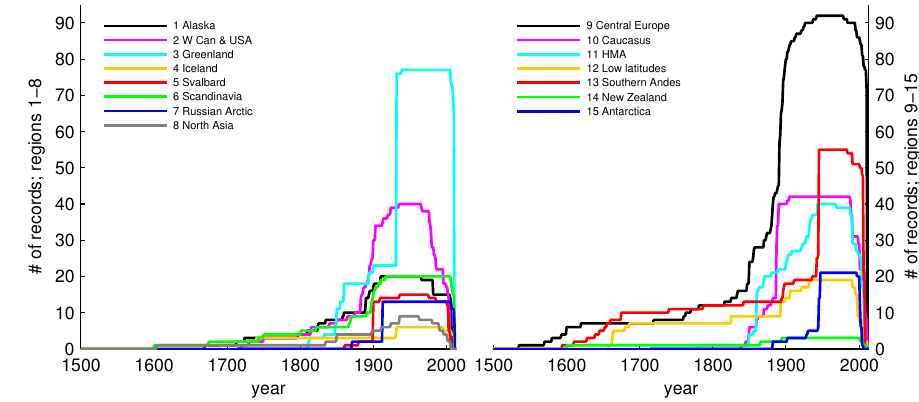
Fig. 7. Number of available glacier length records per region in time. The 15 regions are shown in two graphs for